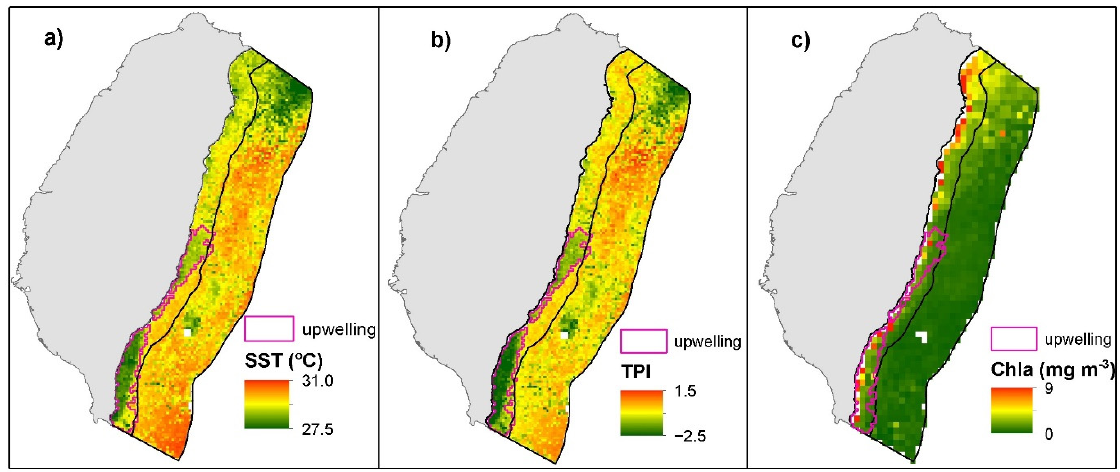
Figure 2. ( a ) The H-8 SST image on 19 July 2016, ( b ) the TPI image calculated from ( a ), ( c ) the H-8 chlorophyll- a image on 19 July 2016. The purple polygons indicate the upwelling areas mapped.